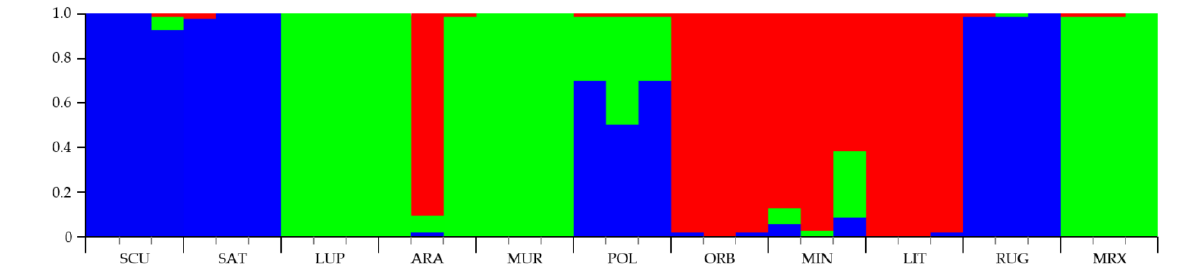
Figure 5. Bar plot of genetic relationships among the 11 Medicago species estimated using STRUC- TURE software based on the data obtained by the four n-SSR loci analyzed. Codes are as follows: SCU, M. scutellata ; SAT, M. sativa ; LUP, M. lupulina ; ARA, M. arabica ; MUR, M. muricoleptis; POL, M. polymorpha ; ORB, M. orbicularis ; MIN, M. minima ; LIT, M. littoralis ; RUG, M. rugosa ; MRX, M. murex . The estimated membership probability (Q) for K = 3 is plotted on the y-axis.